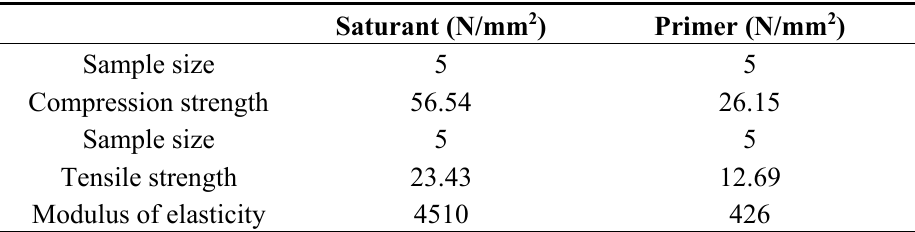
Table 2. Mechanical properties of the epoxy